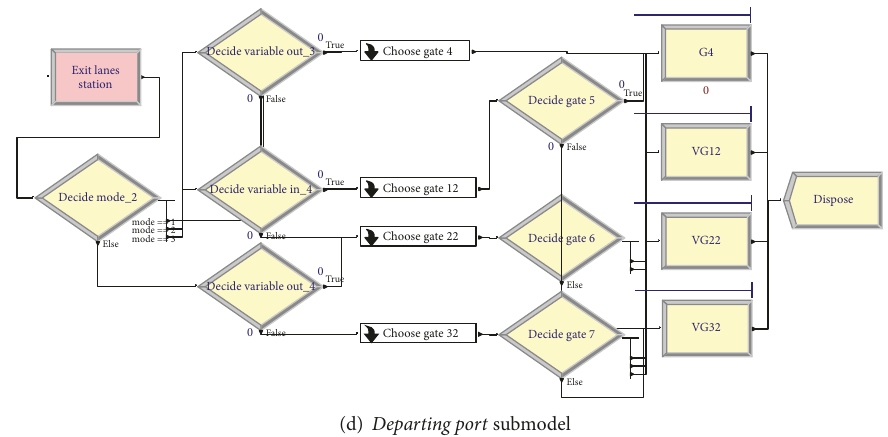
Figure 5: Interface of the simulation model of the container terminal gate system.